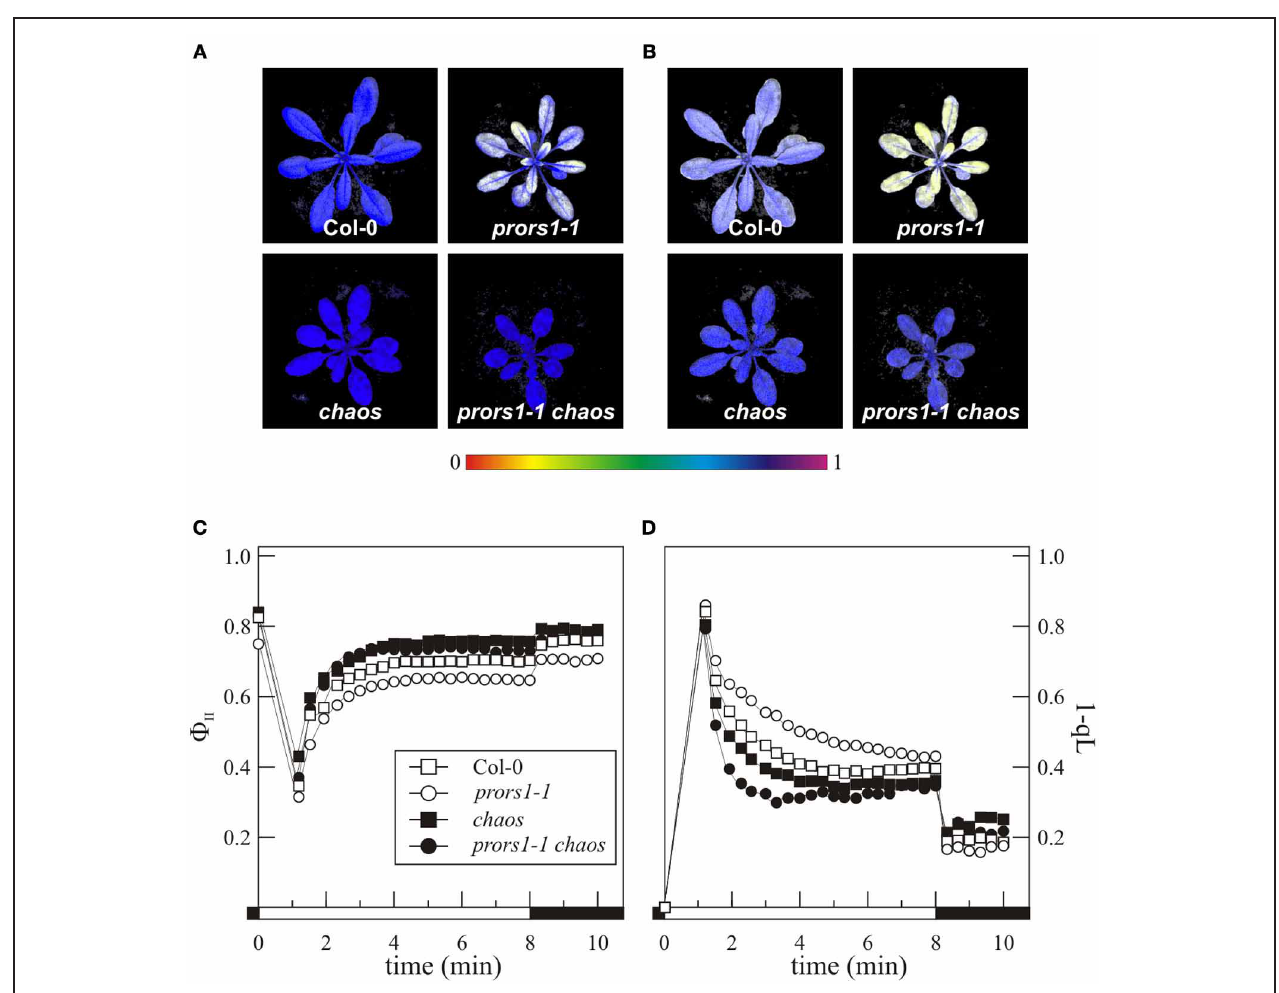
indicated according to the color scale at the bottom of the panel. F indicate dark periods, and white bars light periods. Standard deviations were always below 10%. Leaf pigment content (pmol/mg